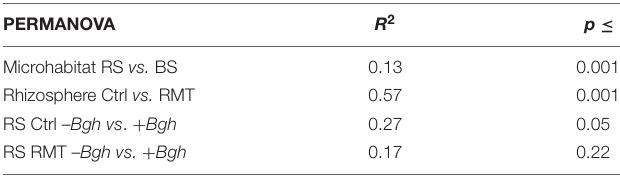
TABLE 1 | PERMANOVA of barley rhizosphere (RS) and bulk soil (BS) samples, either treated with rhizosphere microbiome transplant (RMT) or as control (Ctrl).